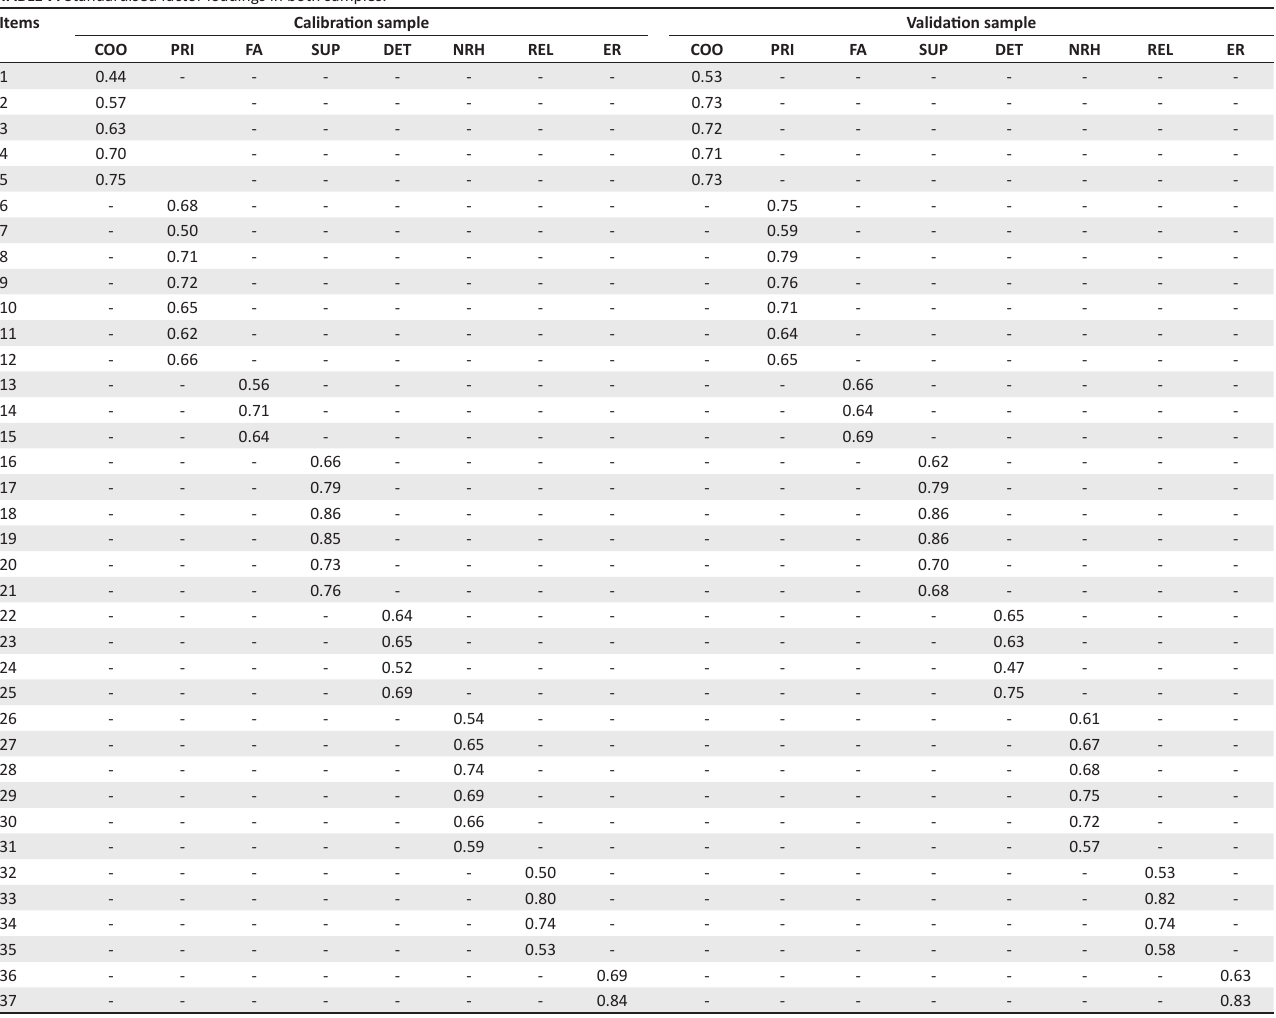
COO, confidence and optimism; PRI, positive reinterpretation; FA, facing adversity; SUP, support; DET, determination; NRH, negative rumination and helplessness; REL, religion; ER, emotional TABLE 7: Standardised factor loadings in both samples. Items